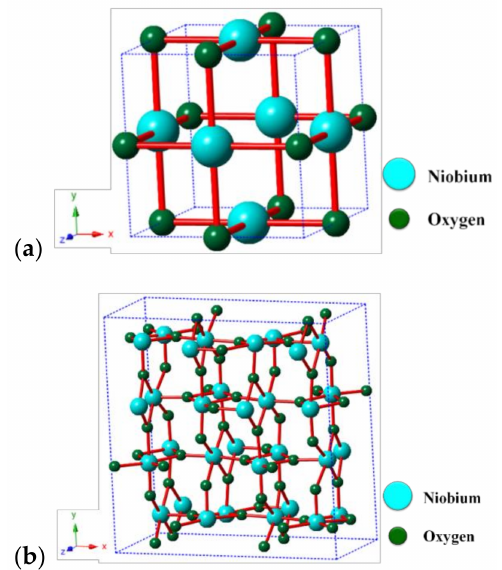
Figure 8. Crystalline structure of the ( a ) NbO and ( b ) NbO 2 unit cells (adapted from [32]). Niobium pentoxide can occur in different phases and usually presents octahedra structure NbO 6 , but due to the polymorphism, other coordination structures can be found, such as NbO 7 and NbO 8 , depending on the crystalline phase, which is a consequence of the synthesis route [40]. Due to its polymorphism, Nb 2 O 5 can be described in distinct phases: amorphous (Nb 2 O 5 · nH 2 O), pseudo-hexagonal (TT-Nb 2 O 5 ), orthorhombic (T-Nb 2 O 5 ), and monoclinic (H-Nb 2 O 5 ) [46]. The T-Nb 2 O 5 and H-Nb 2 O 5 phases are widely studied, the latter being the most thermodynamically stable (Figure 9) [32].